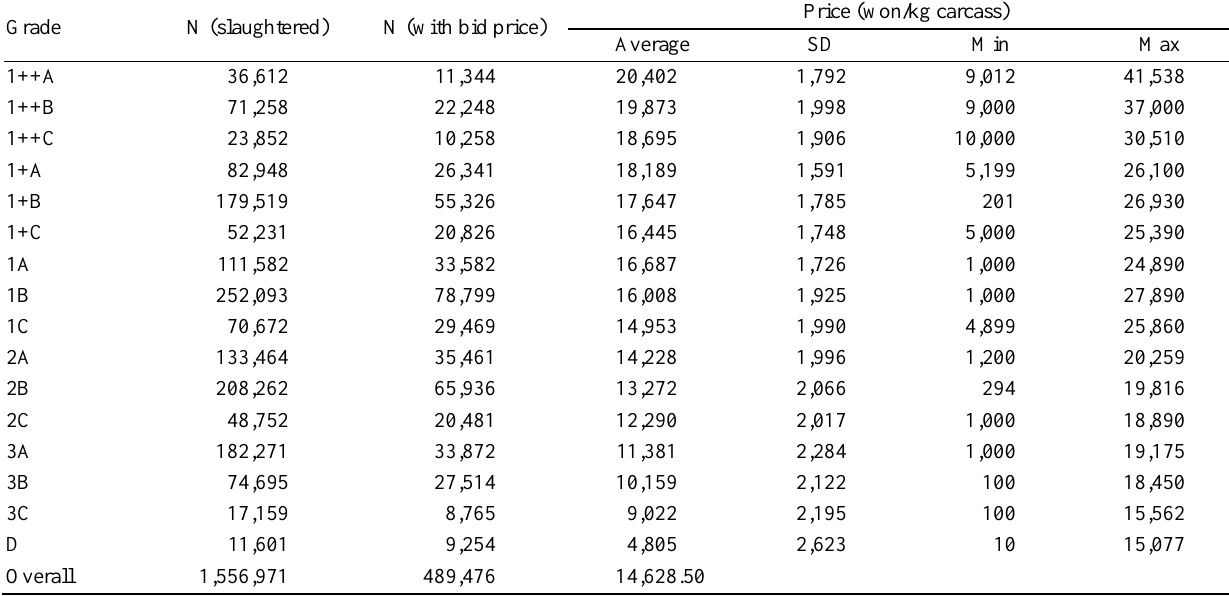
Table 1. Average bid price of the Hanwoo carcasses (won/kg) by final